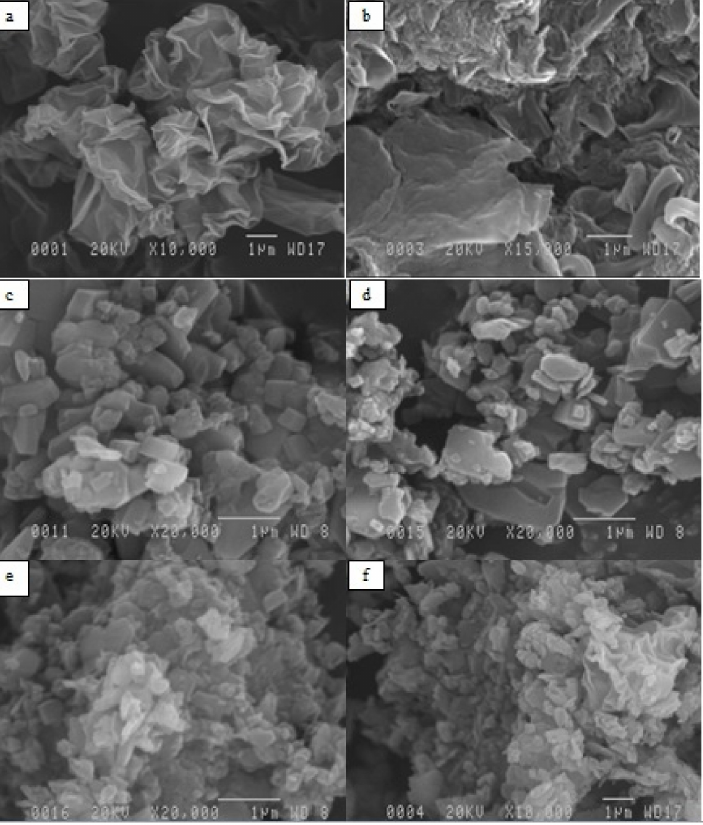
Figure 23. SEM images of ( a ) GO, ( b ) NH 2 -rGO, ( c ) Al-PMOF, ( d ) NH 2 -rGO (5 wt %)/Al-PMOF, ( e ) NH 2 -rGO (15 wt %)/Al-PMOF, and ( f ) NH 2 -rGO (25 wt %)/Al-PMOF